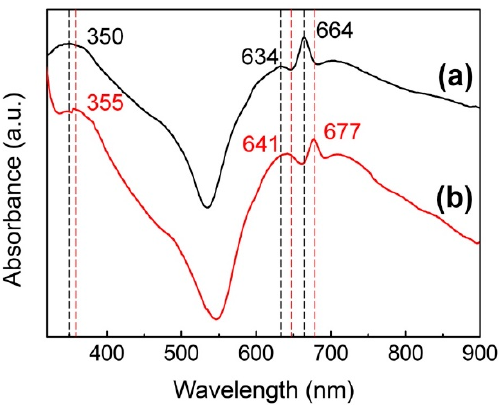
Figure 2. UV-Vis near IR spectra of the ( a ) NiPc/CHCl 3 solution and the ( b ) solid film of NiPc.